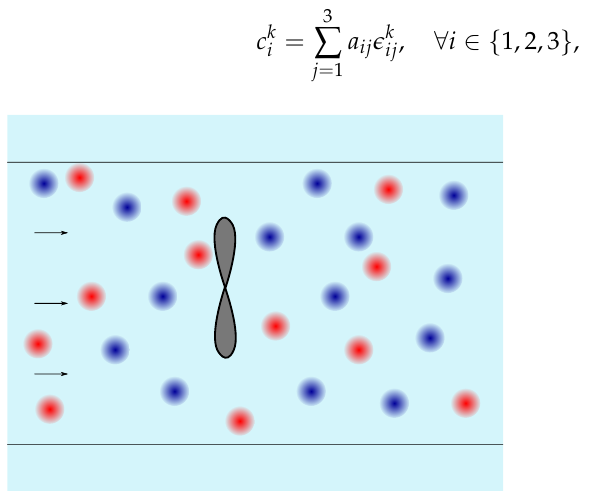
Figure 2. Turbulent structures (red and blue marks) immersed in the incoming